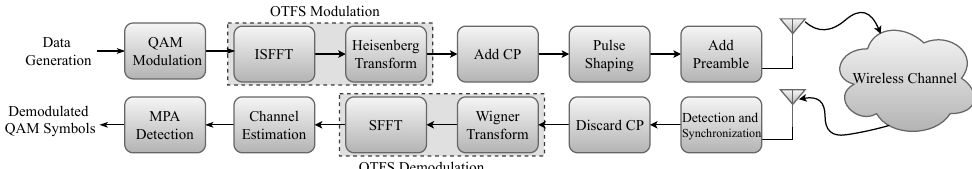
Figure 1. OTFS transceiver block